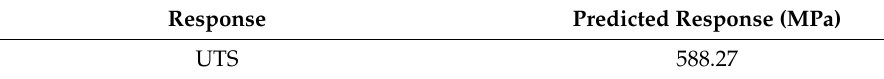
Table 7. Predicted responses UTS of weld executed with optimal flux.